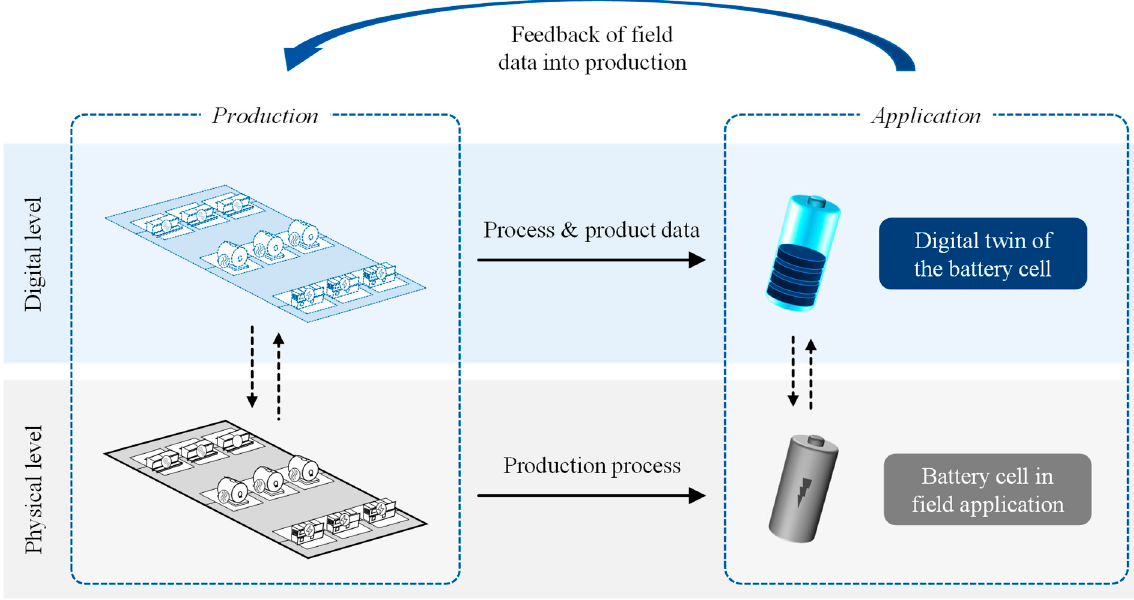
Figure 10. Potential expansion for a digital twin beyond the production boundaries.